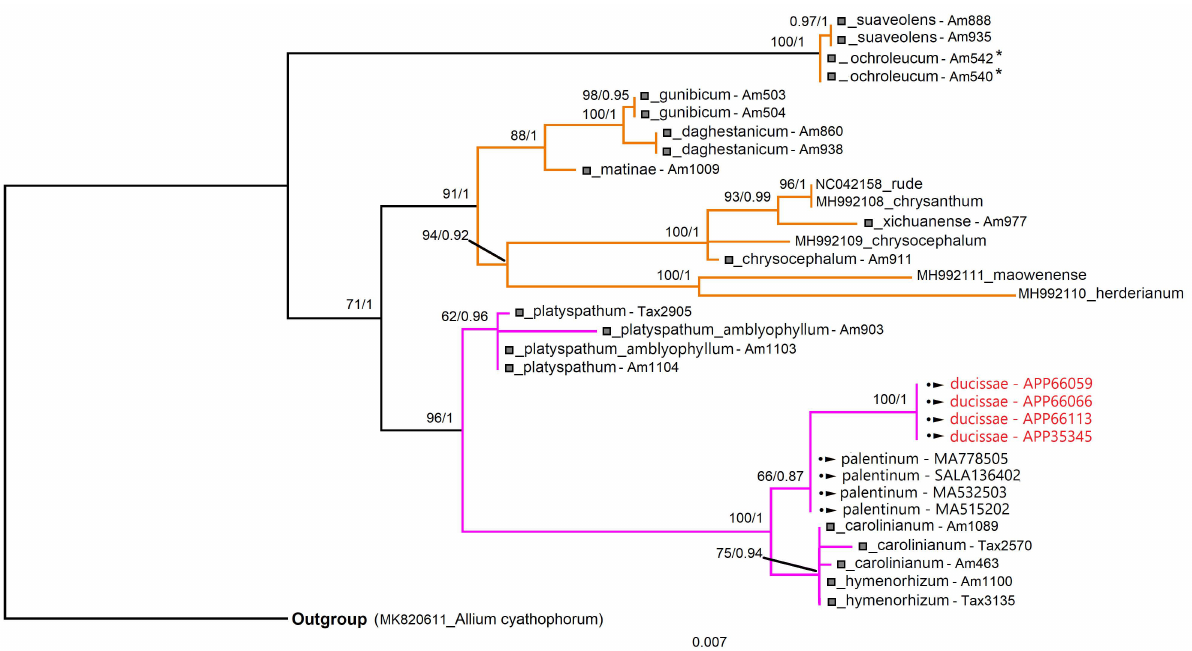
Figure 11. Maximum likelihood (ML) phylogram of newly generated and previously published plas- tid sequences of Allium ( trn Q (UUG) - rps 16, trn L (UAA) - trn F (GAA) , and rp L32- trn L (UAG) IGS) (GenBank code or symbol ( (cid:3) ) + specific epithet). The symbol ( (cid:3) ) indicates that the sample has three GenBank codes corresponding to the analyzed markers. A single Genbank code corresponds to the plastid genome of the specimen. The newly generated sequences have symbol ( • (cid:73) ) and in red the samples of A. ducissae sp. nov. Accessions belonging to A. sect. Daghestanica are shown with orange branches and sect. Falcatifolia in pink. ML bootstrap values followed by Bayesian posterior probabilities are shown above the branches (BS/PP values > 50%). *, species reported in Freisen et al. [25] as A. ericetorum Thore. For information of the samples see Supplementary Table S1 and for concatenated cpIGS matrix see Supplementary File